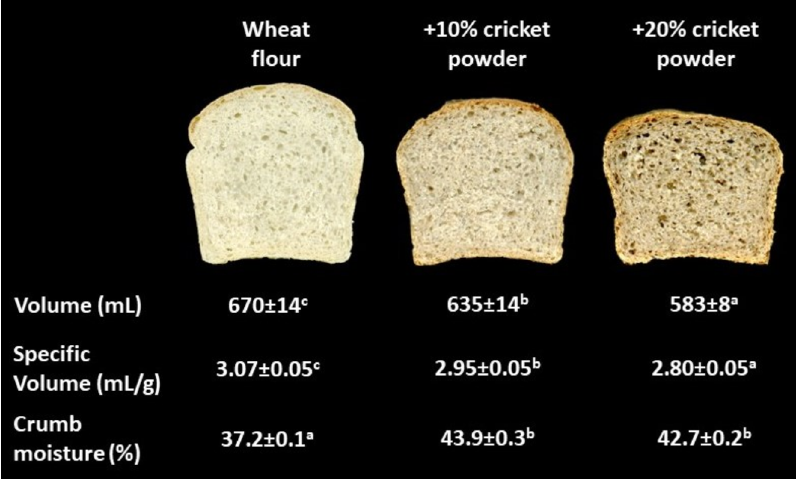
Figure 5. Pictures of the crumb, and quality indices (volume, specific volume, and crumb moisture) of bread prepared from wheat flour alone, and with increasing replacement level of cricket powder (10% and 20%). Data are expressed as mean ± standard deviation. Different letters in the same row correspond to significant differences (one-way ANOVA, Tukey’s HSD test, p ≤